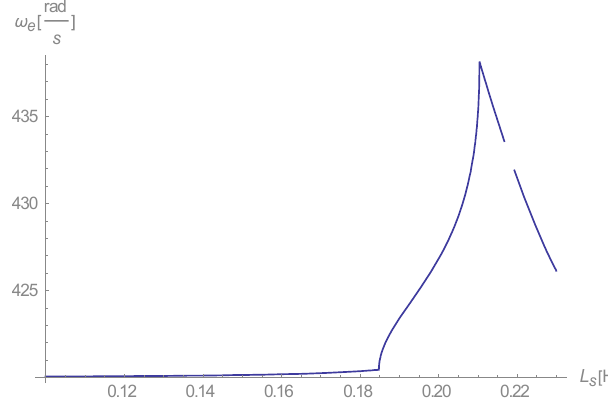
Figure 10. Plot of the real part of the fourth solution of ω e (L S ).